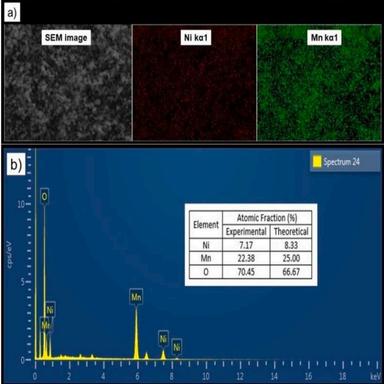
a) EDS mapping of Ni and Mn on the surface of the as-prepared sample of LNMO and b) EDS spectrum of an as-prepared sample of LNMO with an atomic fraction (inset table).